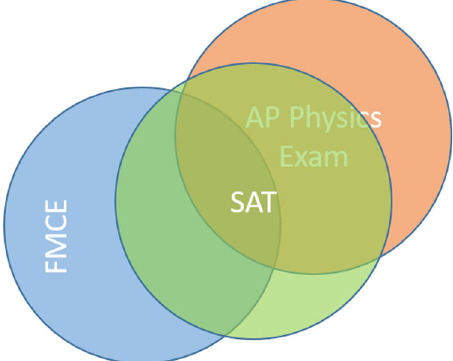
FIG. 3. Illustration of overlap between score variation on the FMCE, the math SAT, and the AP physics